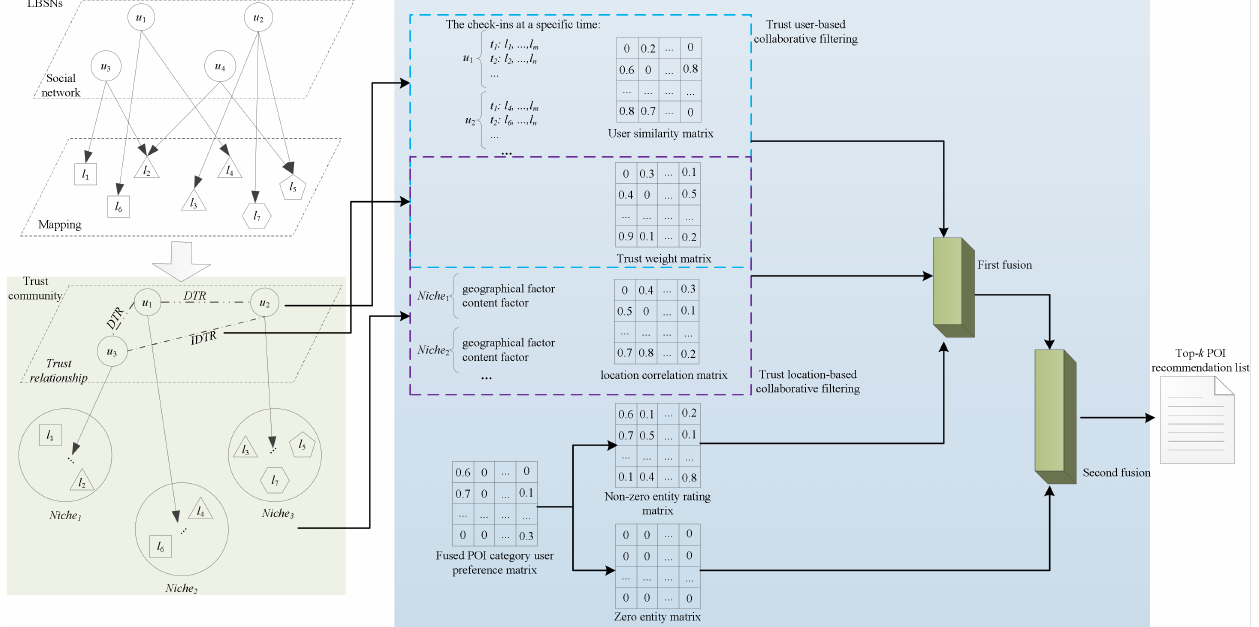
Figure 1. The overview of the proposed model. Green-filled area represents the proposed trust community framework, and the blue one denotes the methodology based on the trust community framework, including the trust-enhanced collaborative filtering from the views of users and locations and the two-step data